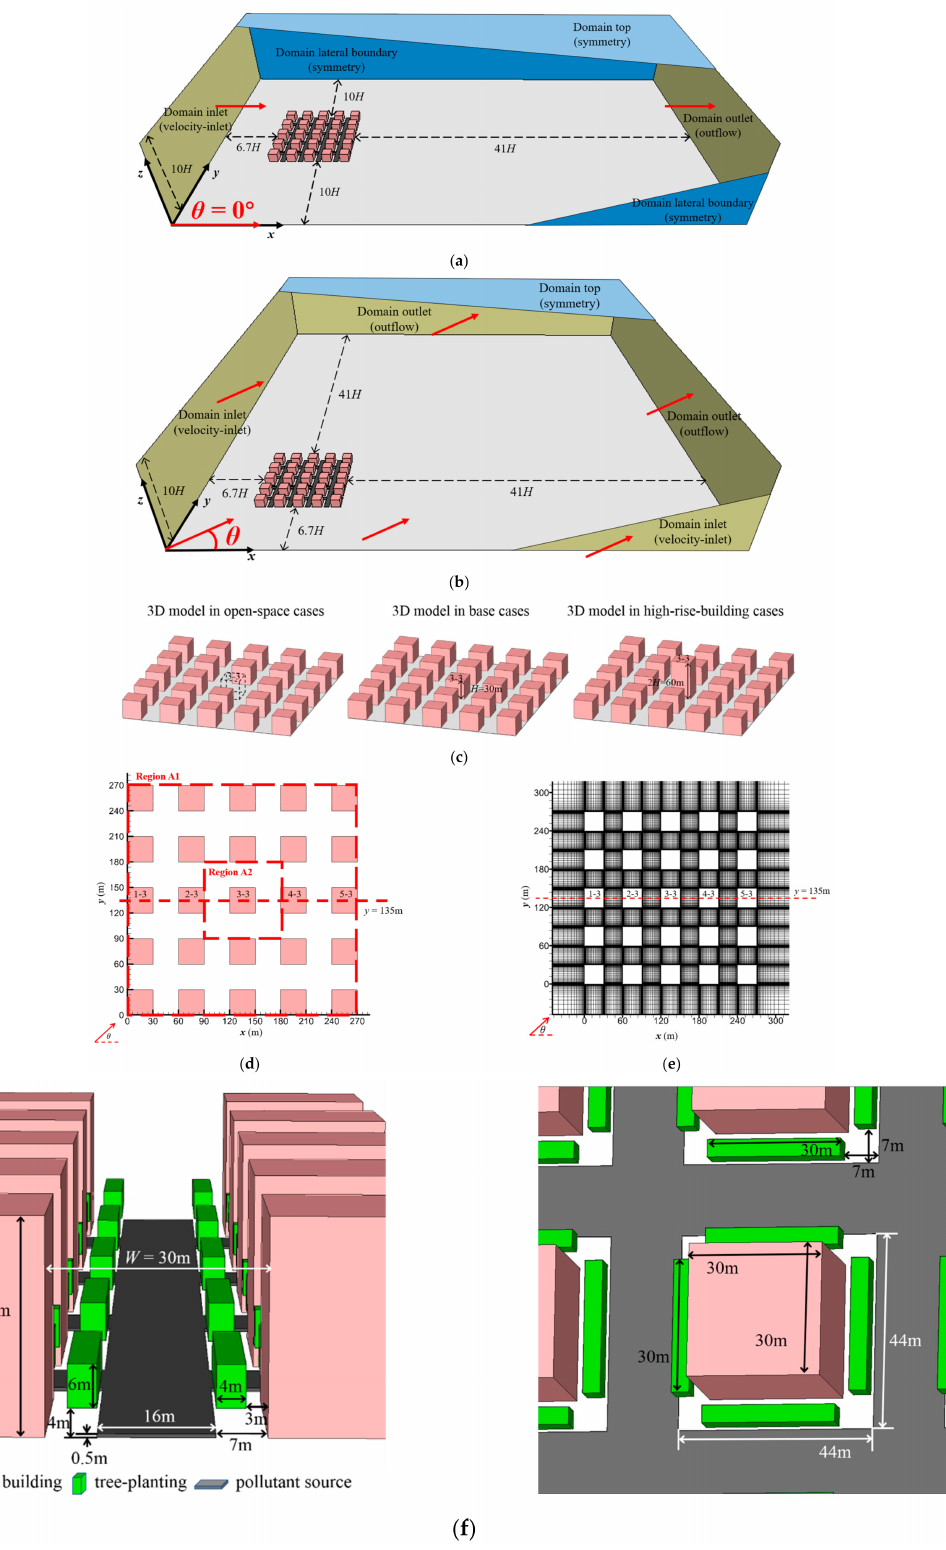
Figure 1. Computational domain of ( a ) Case [Base, 0 ◦ ] and ( b ) Case [Base, θ ] ( θ = 15 ◦ , 30 ◦ , 45 ◦ ). ( c ) 3D model description of open-space cases, base cases and high-rise-building cases. ( d ) Model description and ( e ) grid arrangements from top view in base cases. ( f ) Setups of building, tree planting and pollutant